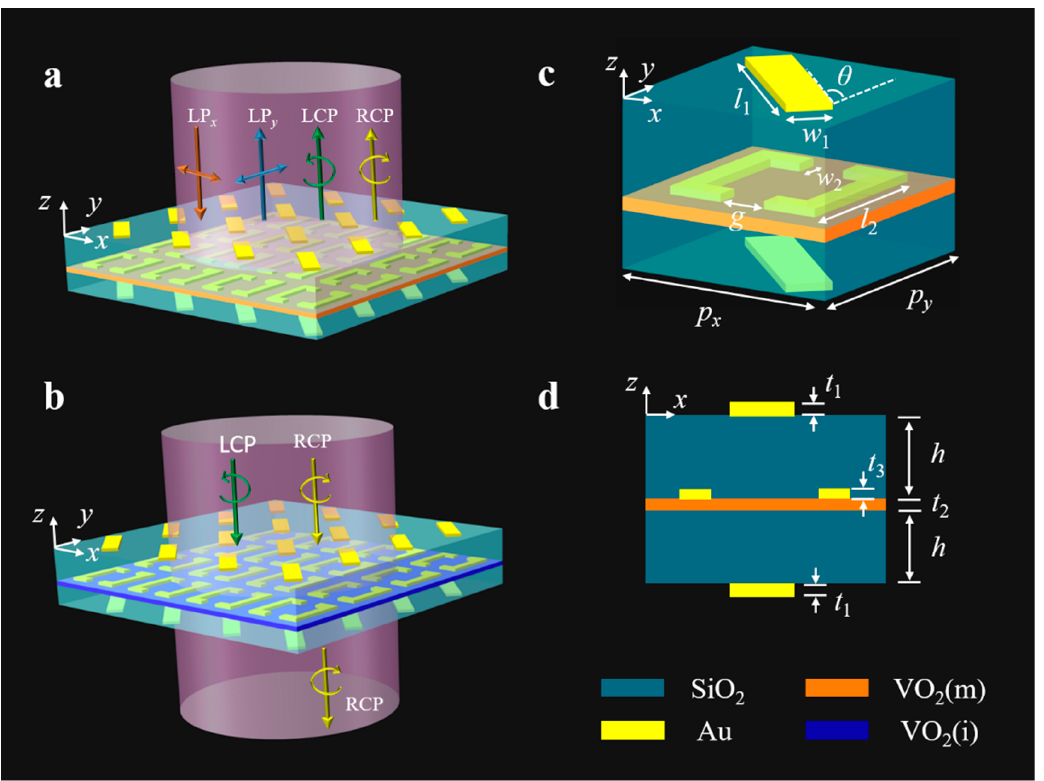
Figure 1. Schematic of the proposed metamaterial with 3 × 3 unit cells under x - and y -polarized waves when VO 2 is in the ( a ) metallic and ( b ) isolating states, respectively. ( c ) A unit cell of the proposed metamaterial. ( d ) The side view of the proposed structure in the x - z plane. The optimized geometric parameters are listed as below: p x = p y = 20 μ m, l 1 = 29 μ m, l 2 = 24 μ m, w 1 = 7 μ m, w 2 = 4 μ m, t 1 = 0.7 μ m, t 2 = 0.7 μ m, t 3 = 0.6 μ m, g = 4 μ m, h= 9.65 μ m.